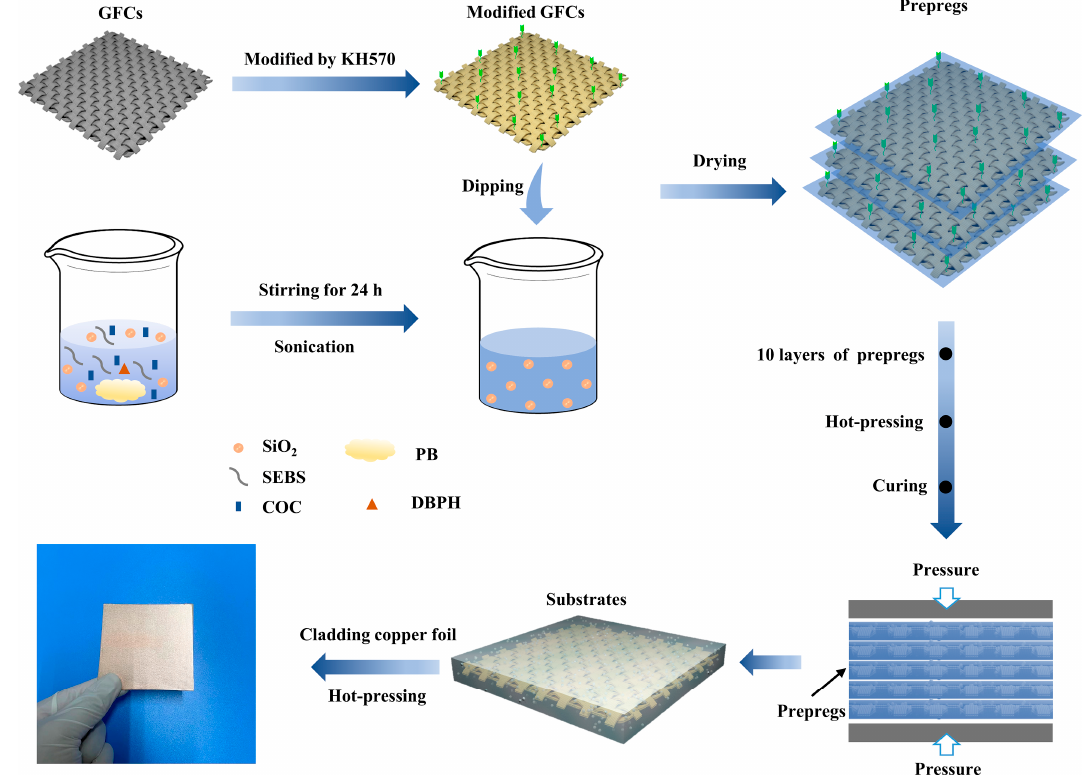
Figure 1. Process of sample preparation.